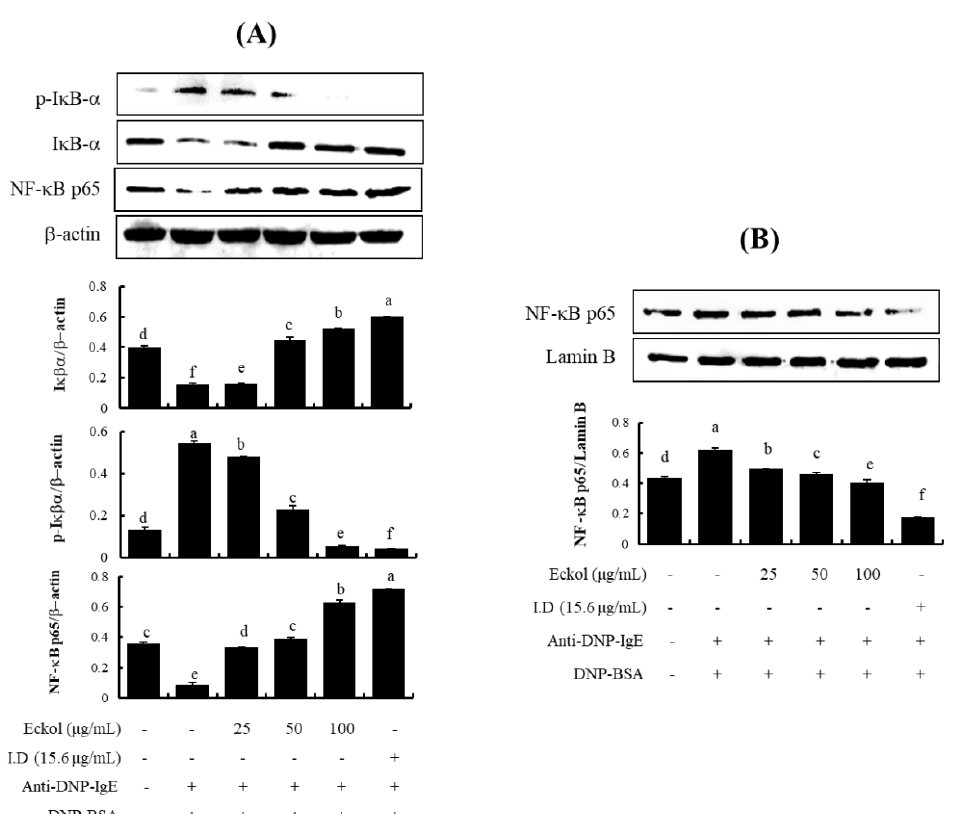
Figure 5. E ff ect of eckol on I κ B- α and NF- κ B activation in IgE / BSA-stimulated BMCMC. ( A ) I κ B- α Figure 5. Effect of eckol on I  B- α and NF -  B activation in IgE/BSA-stimulated BMCMC. ( A ) I  B- α activity in the cytosol and ( B ) NF- κ B activity in the nucleus. Data are expressed as means ± SD ( n = 3) activity in the cytosol and ( B ) NF-  B activity in the nucleus. Data are expressed as means ± SD ( n = 3) of three individual experiments. Di ff erences in mean values among groups were assessed by one-way of three individual experiments. Differences in mean values among groups were assessed by one-way analysis of variance followed by Duncan’s test using PASW statistics 21.0. A value of p < 0.05 was analysis of variance followed by Duncan’s test using PASW statistics 21.0 . A value of p < 0.05 was considered statistically considered statistically significant.